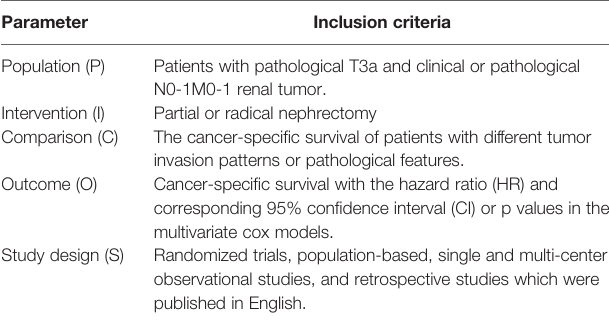
TABLE 1 | The Population, Intervention, Comparison, Outcome and Study design (PICOS) framework of the review.